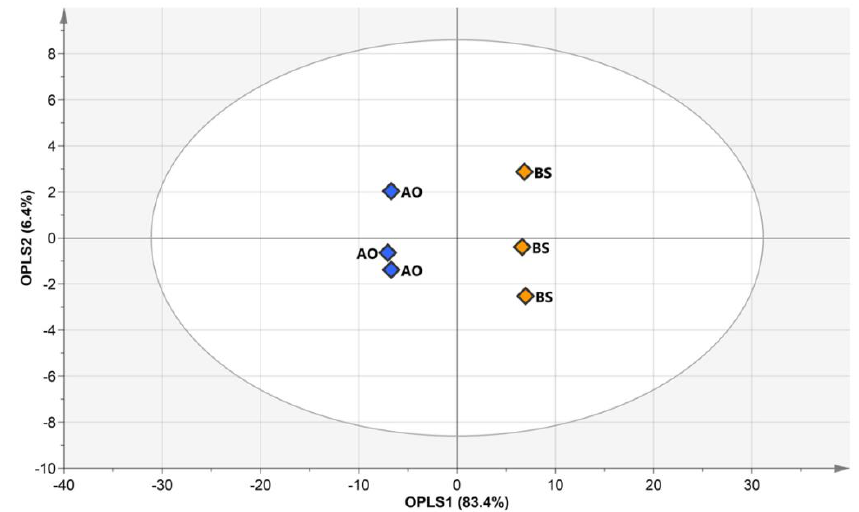
Figure 5. Orthogonal partial least squares discriminant analysis score plots for hydrophilic metabolite, lipophilic metabolite, fatty acid, isoflavone, and raffinose data of soybeans fermented by Aspergillus oryzae (AO, blue symbols) or Bacillus subtilis (BS, yellow symbols) after water extraction at 55 °C.